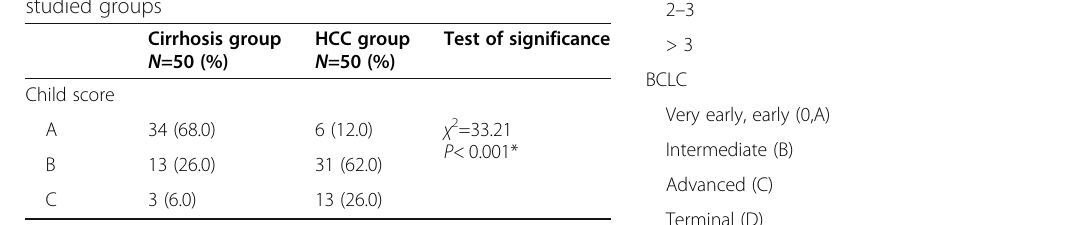
Table 4 Child – Pugh score classification distribution among